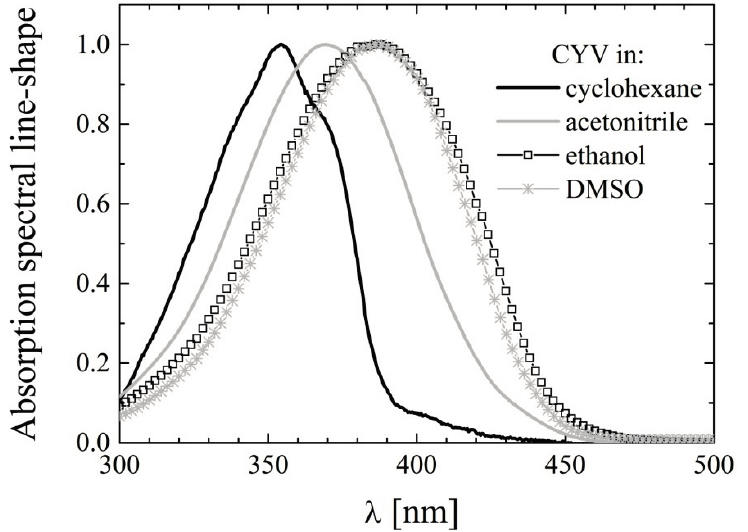
Figure 3. Charge-transfer absorption bands of CYV in selected solvents: cyclohexane (black line), acetonitrile (gray line), ethanol (squares) and dimethylsulfoxide